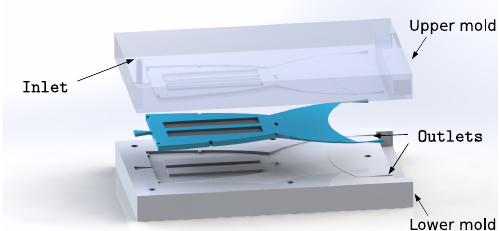
Figure 1. Cast mold for the robot’s body. The two halves form the cavity for the textile-elastomer compound inside. The silicone mixture is pressed through the cast mold, injected on the inlet, and overfilled towards the